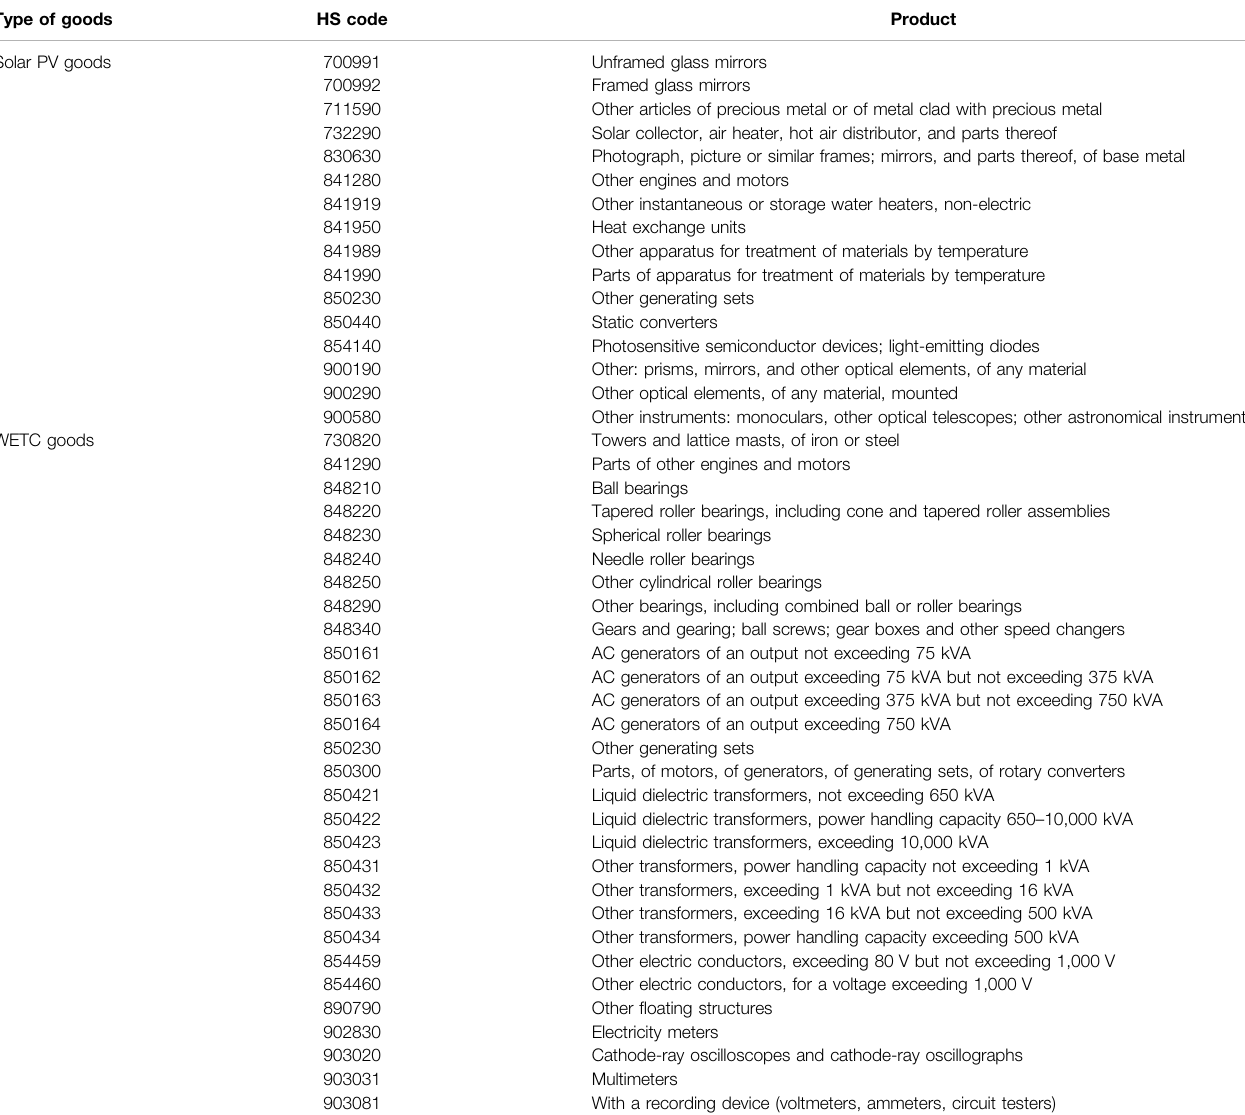
TABLE 1 | HS codes used for the solar PV and WETC goods (Sourced from Kuik et al., 2019). Type of